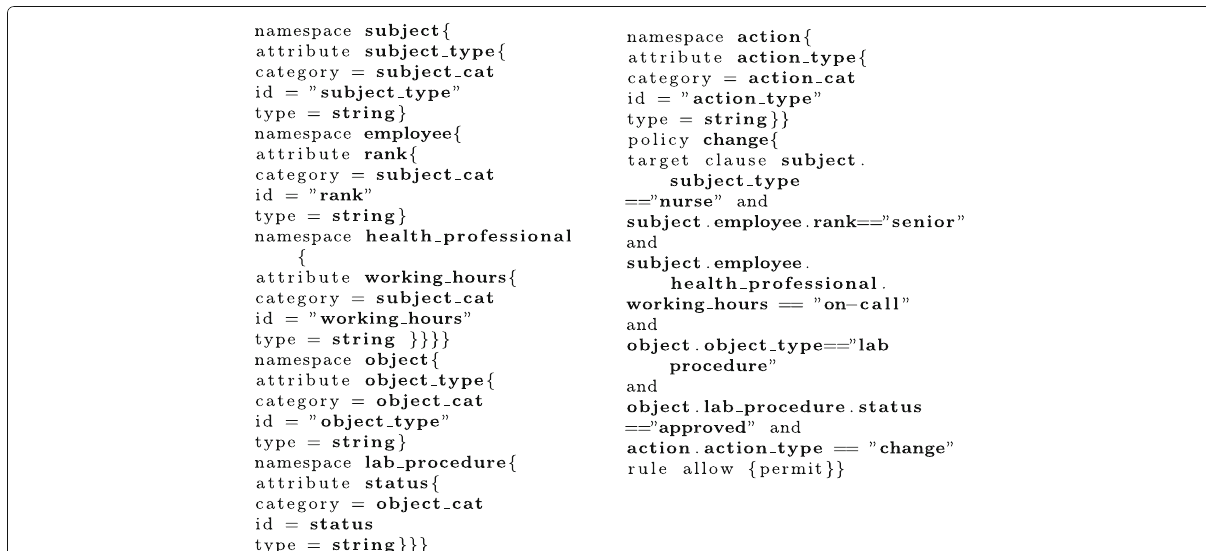
Fig. 3 The machine-readable form of a policy sentence “An on-call senior nurse may change the list of approved lab procedures.” Bold-ed portions of text correspond to attribute properties as obtained from Table 1